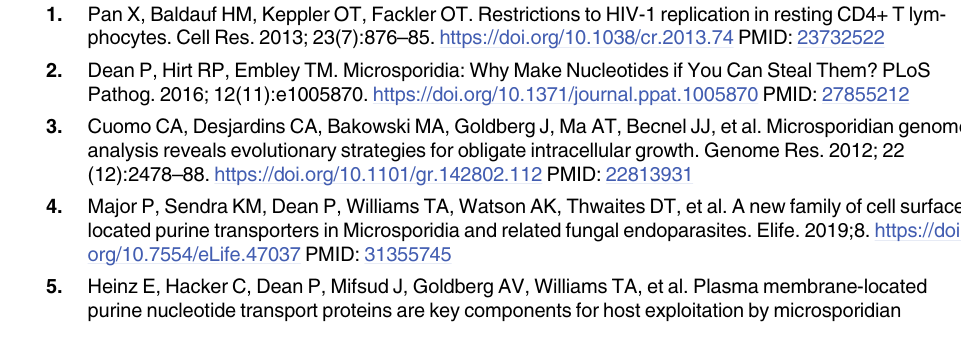
S6 Table. Detailed GSEA results. S7 Table. Detailed results of hypergeometric testing. S8 Table. Detailed GO Term results. S9 Table. Detailed Wormcat results. S10 Table. Detailed list of overlaps of upregulated genes in pnp-1 mutants and those upre- gulated by PA14 infection, in pmk-1 mutants or in sek-1